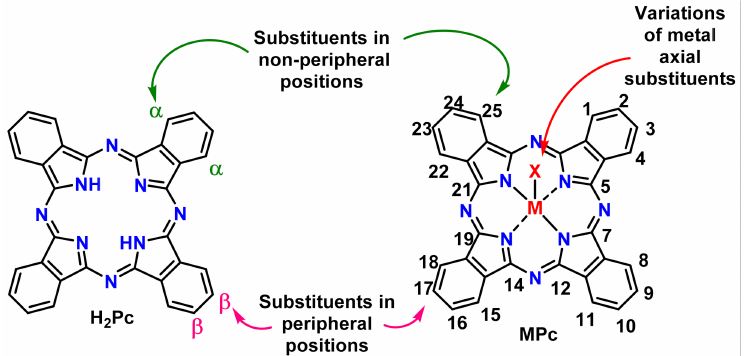
Figure 1. General structure of metal-free phthalocyanine ( left ) and metal phthalocyanine complex ( right ), with schematic representation of possible structural modulation sites and ring